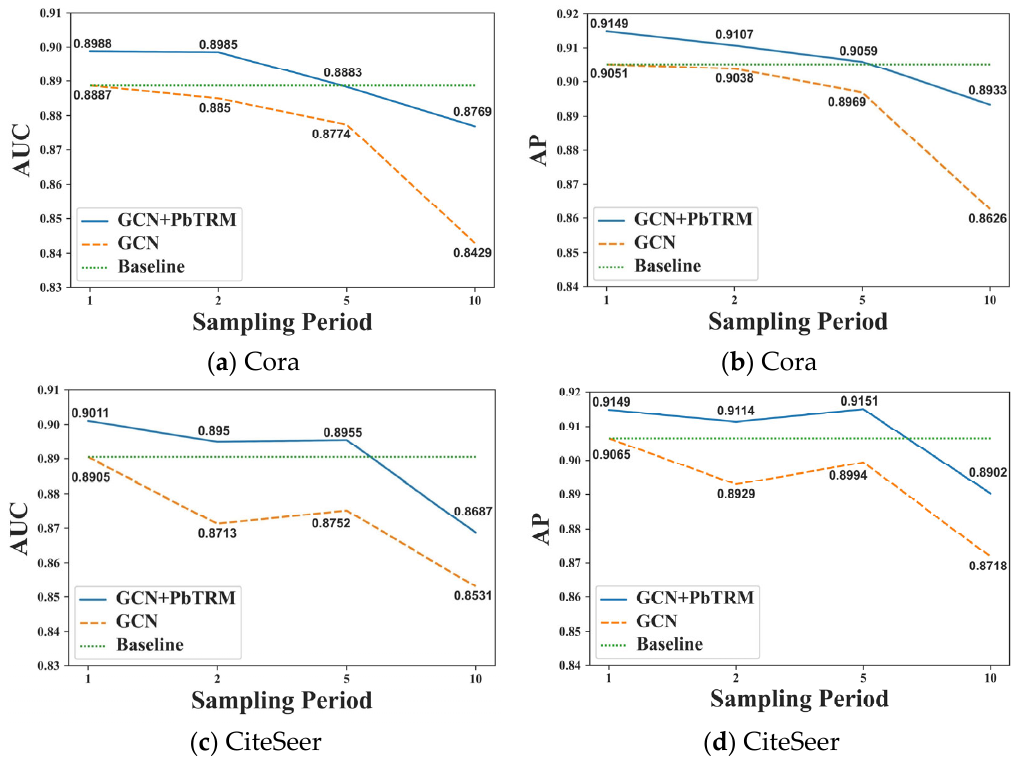
Figure 4. The changes in prediction performance of GCN+PbTRM and benchmarking GCN models on different 𝑇 values of a sampling period.